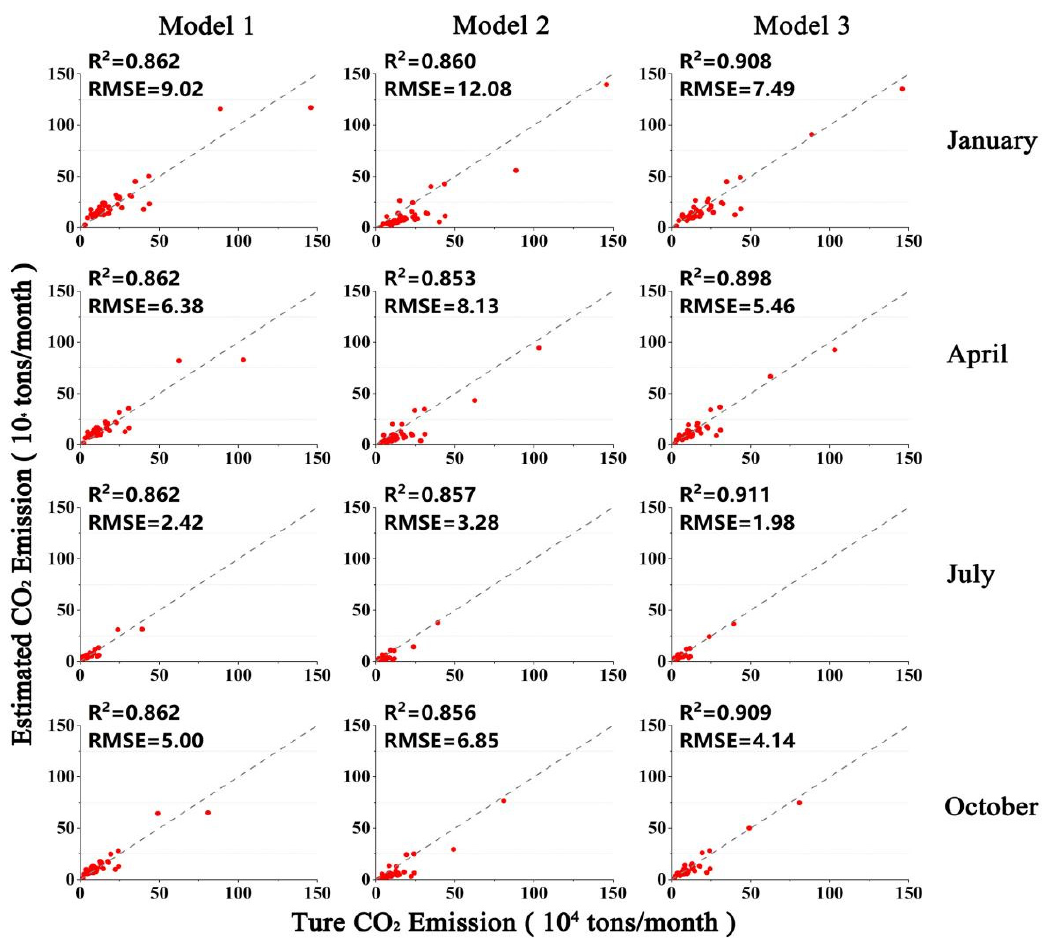
Figure 6. Scatter-plot of true and estimated CO 2 emissions from buildings at county scale for three models. Each point in a scatterplot represents a county, and there are 46 points in each scatterplot.